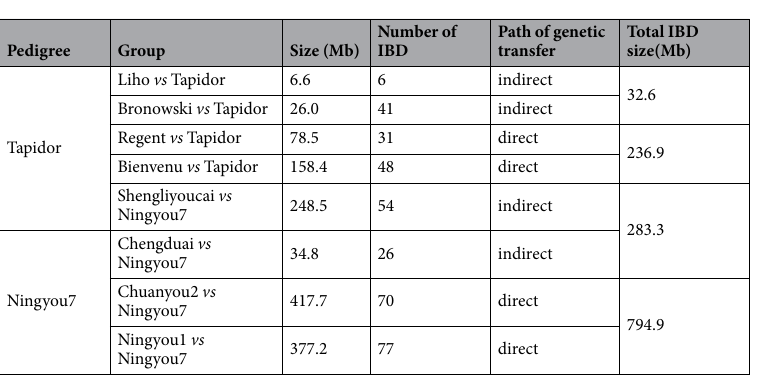
Table 1. Number and total size of identity by descent (IBD) blocks by direct and indirect genetic transfer in the breeding of Tapidor and